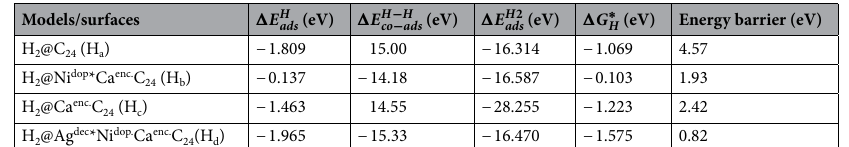
H E H 2 ads , (cid:31) ads